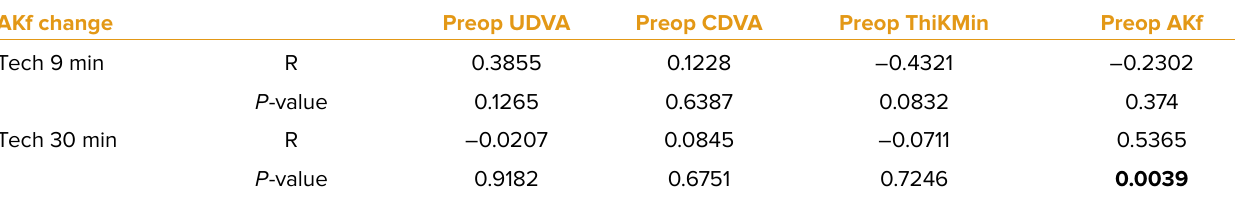
Table 5. Correlation between AKf Change at follow-up and preoperative assessment variables